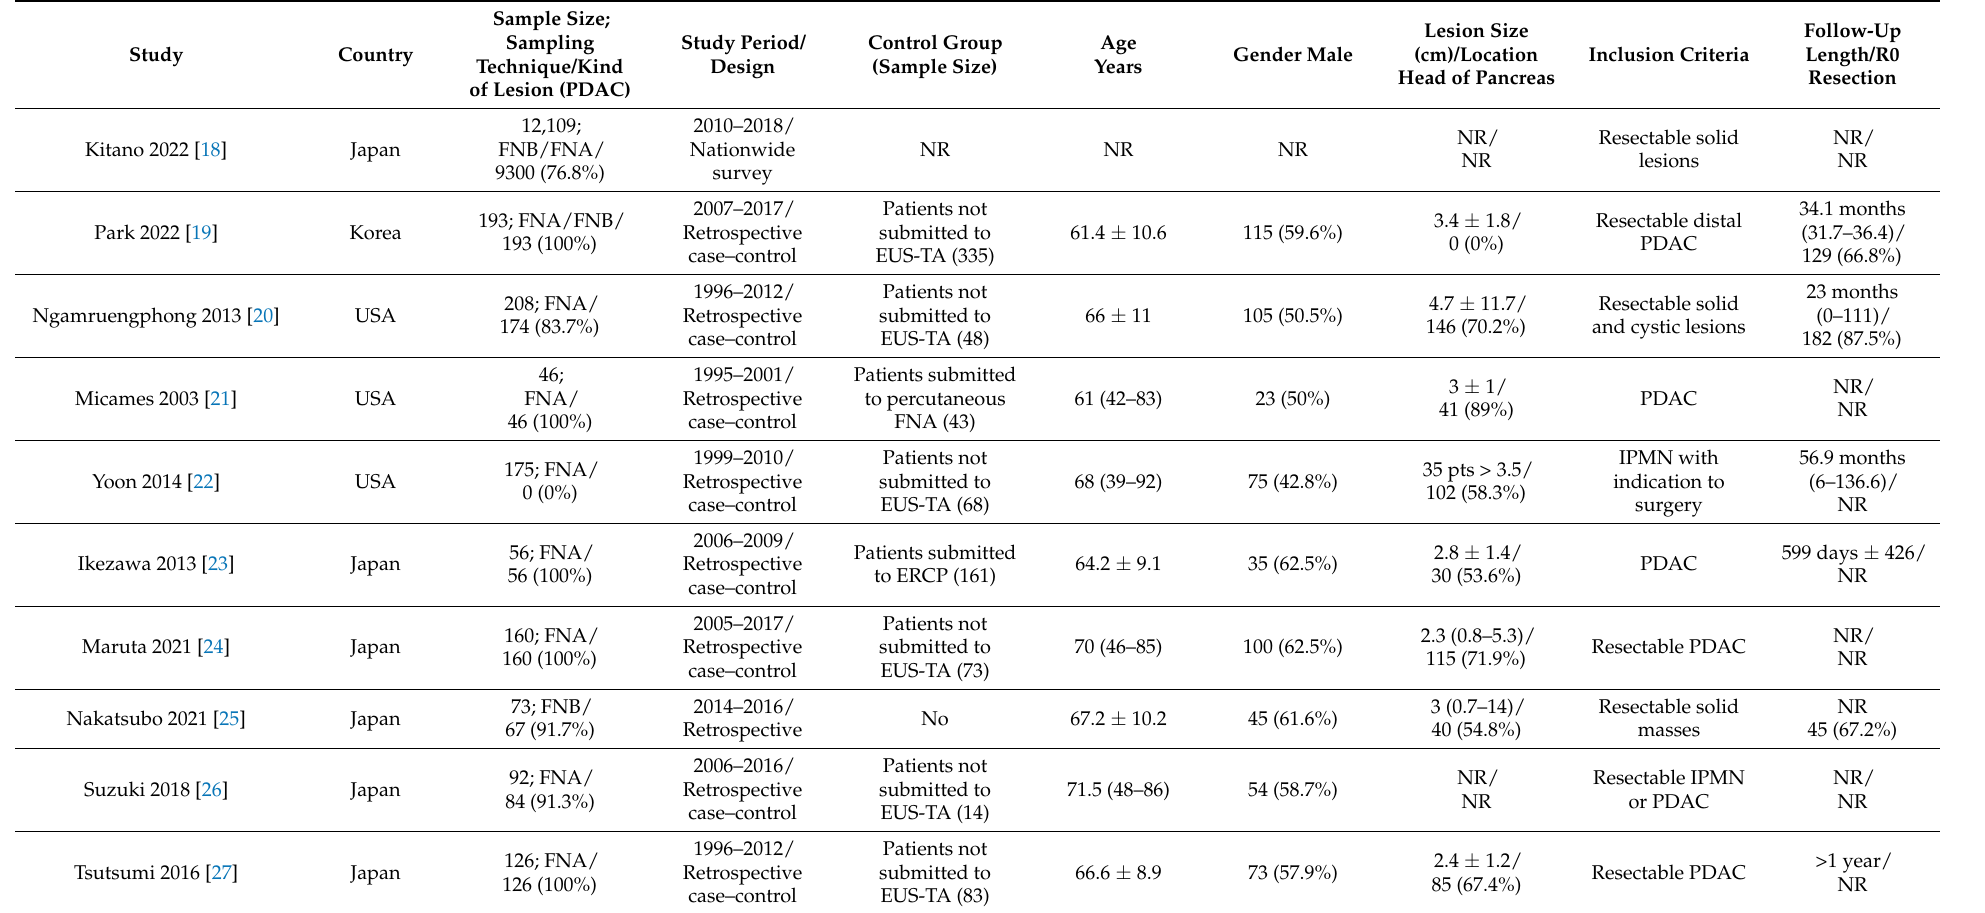
Table 1. Characteristics of included